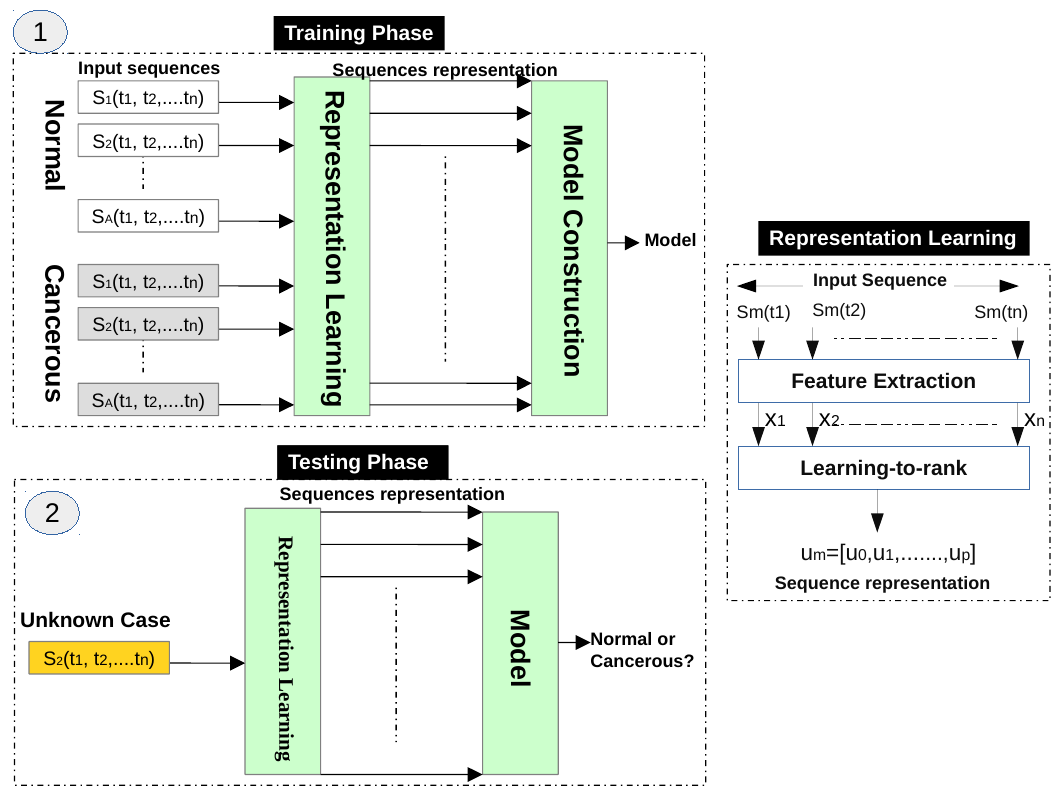
Figure 2. The training and testing phases of the proposed